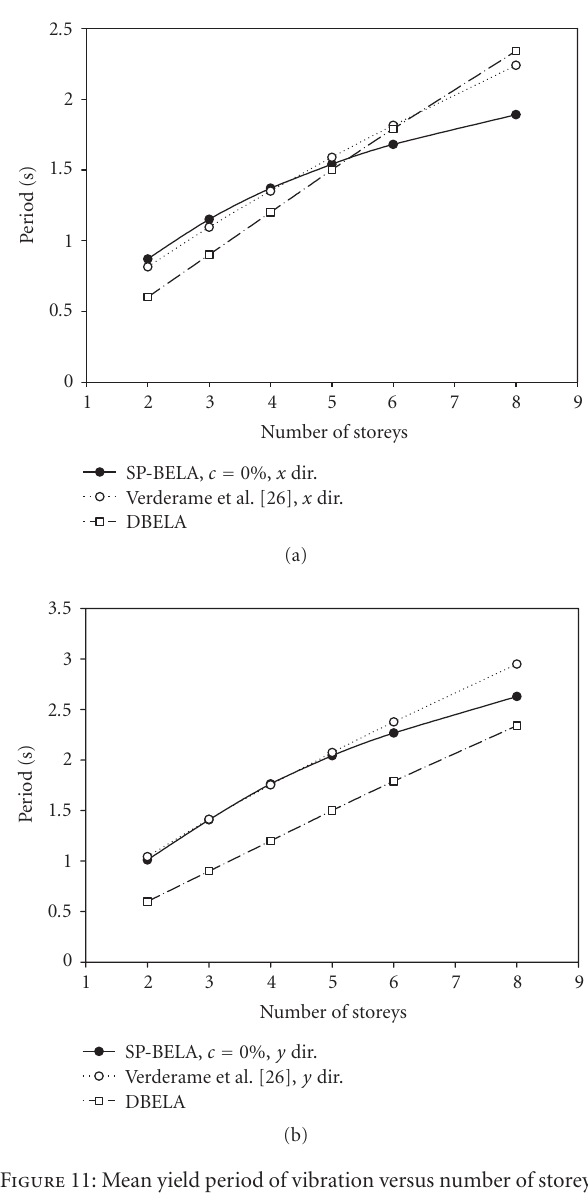
Figure 11: Mean yield period of vibration versus number of storeys for DBELA compared with nonseismically designed ( c = 0%) SP- BELA frames and the equations proposed by Verderame et al. [27], (a) the x direction and (b) the y direction of the buildings.